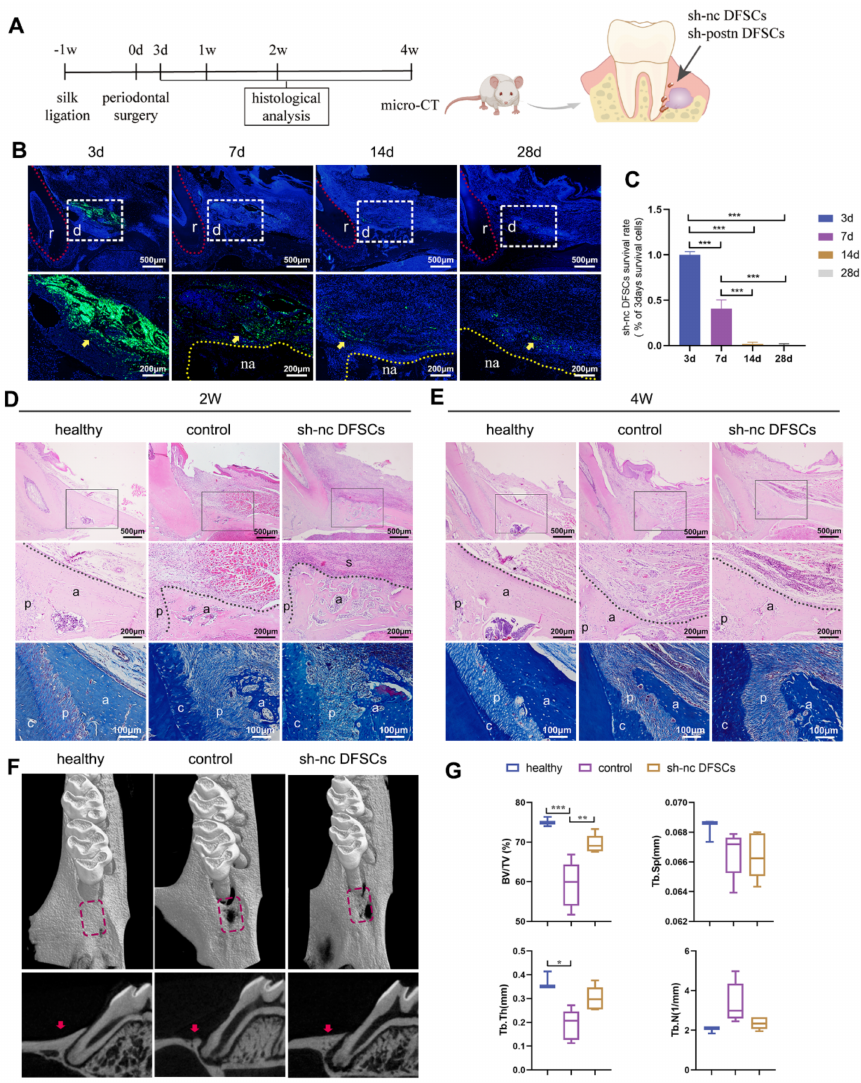
Figure 1. The therapeutic effect and survival rate of DFSCs. ( A ) Schematic illustration of animal model. Fluorescence images ( B ) and related analysis ( C ) of DFSC survival. The red dotted line indicates the root. The data were analyzed by one-way analysis of variance (ANOVA) and Bonferroni post hoc test (n = 3). The white dashed box indicates the defect area. The yellow dotted line indicates the alveolar bone. The yellow arrow indicates DFSCs. r: root; d: defect area; na: newly formed alveolar bone. HE and Masson’s trichrome (MT) staining at 2 weeks ( D ) and 4 weeks ( E ). Middle panel represents a magnified view of the black box in the upper panel. The black dotted line shows the newly formed alveolar bone. a: alveolar bone; c: cementum; p: periodontal ligament, s: DFSC sheet. Micro-computed tomography (micro-CT) images ( F ) and quantitative assessment ( G ) of the defect area at 4 weeks (n = 5). The data of Tb.Sp and Tb.N were analyzed by one-way ANOVA and Bonferroni post hoc test. The data of Tb.Th did not follow normal distribution and were analyzed by Kruskal-Wallis test. The rectangular area and red arrow indicate the defect area in the 3D and sagittal views, respectively. * p < 0.05; ** p < 0.01; *** p < 0.001. Error bars represent means ±